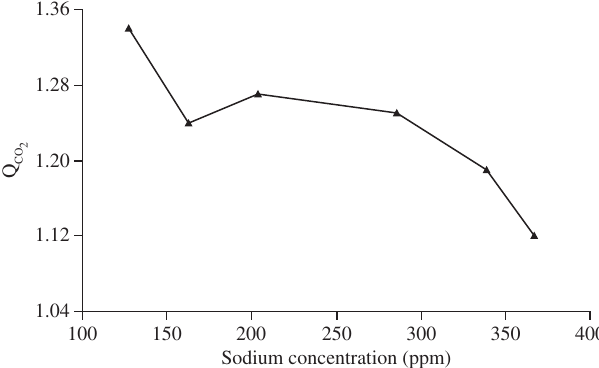
Figure 3. Quality figure to the CO centration (ppm).